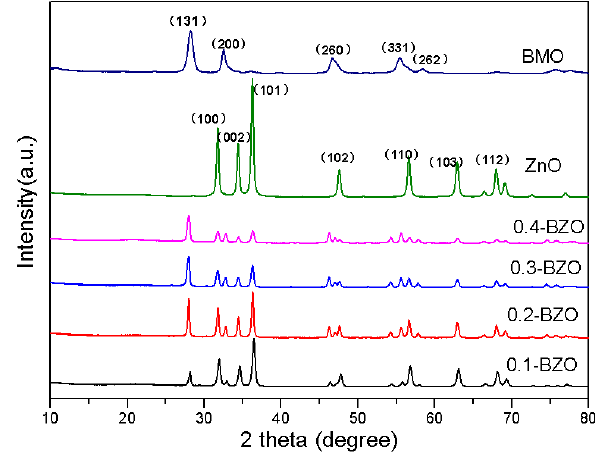
Figure 1. XRD pattern of BMO, ZnO, and BZO.